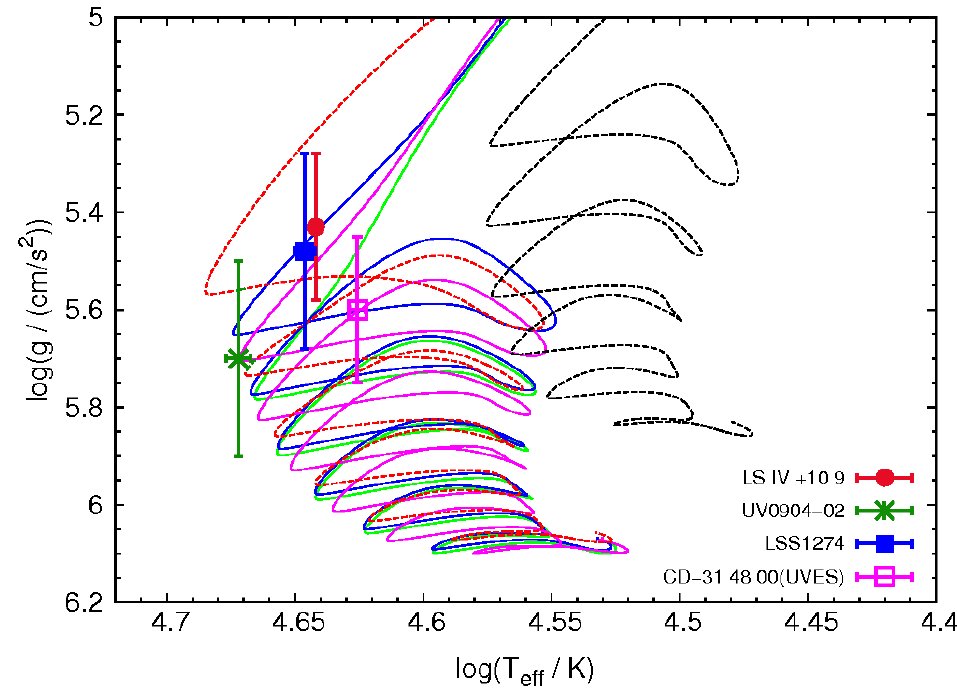
Figure 6. Kiel diagram with evolutionary tracks for deep mixing and different stellar masses (red, blue, green and purple) and shallow (black dashed) mixing hot flasher scenarios.